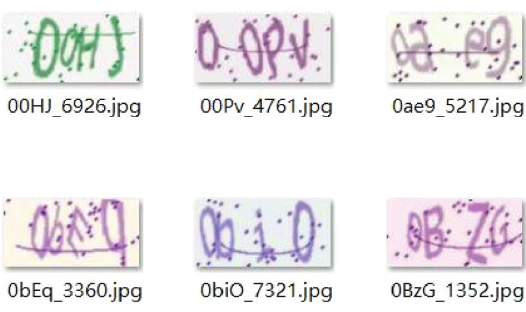
Figure 6: Random generated